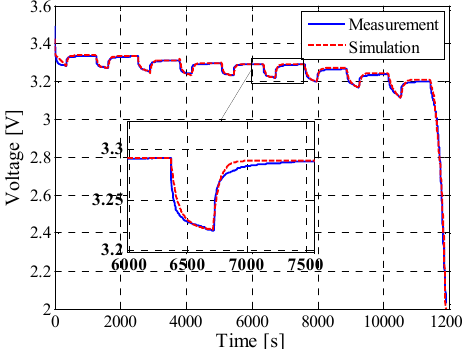
Figure 20. Measured and estimated voltage profiles during pulse discharging of the LFP/C battery ( I bat = 2.5 A, T = 25 °C).